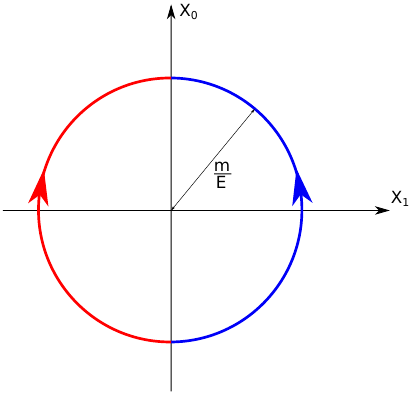
Figure 1 . Worldline instanton for particle-antiparticle pair production in an external electric (cid:12)eld E